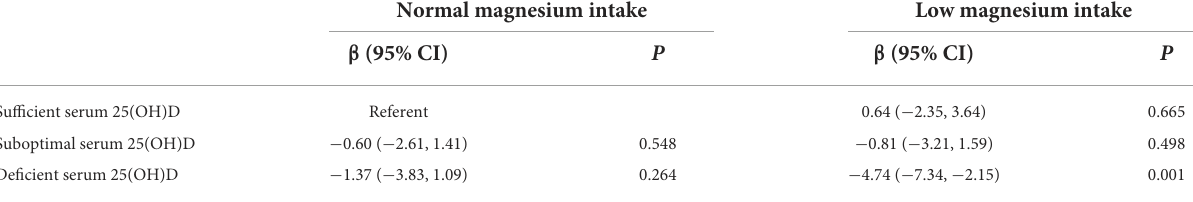
TABLE 3 Combined associations of low magnesium intake and serum 25(OH)D level with handgrip